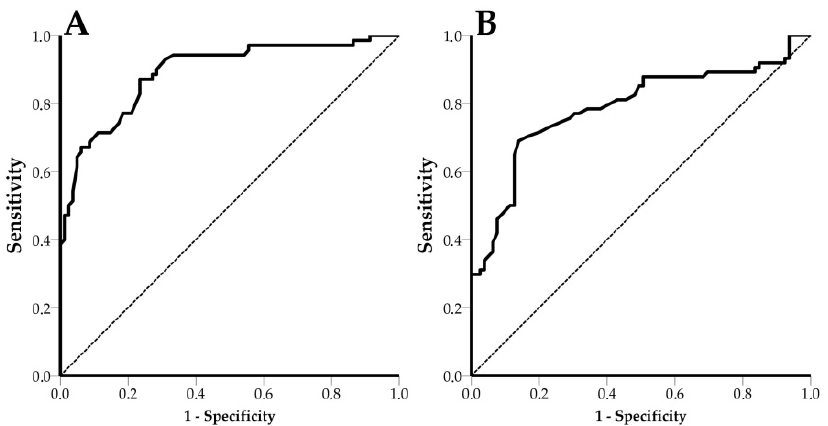
Figure 9. ROC curves for PPV and PCV-2 after the exclusion of the outlier, PIC #45. The dashed line represents the diagonal reference line. ( A ) PPV ROC curve, AUC = 0.892, CI: 0.840 to 0.944, p < 0.0001 and ( B ) PCV-2 ROC curve, AUC = 0.788, CI: 0.712 to 0.863, p < 0.0001.